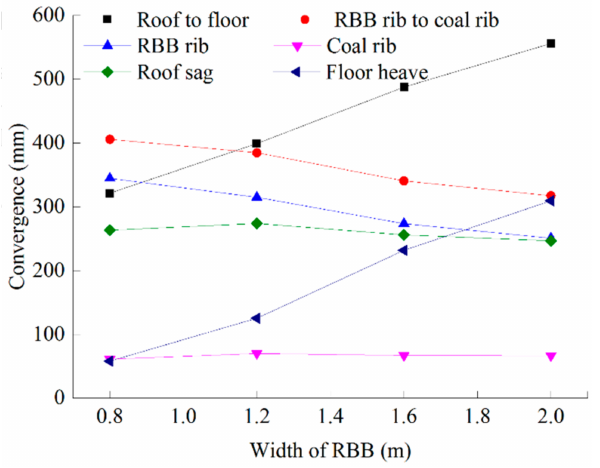
Figure 9. GER convergence with respect to the width of RBB.